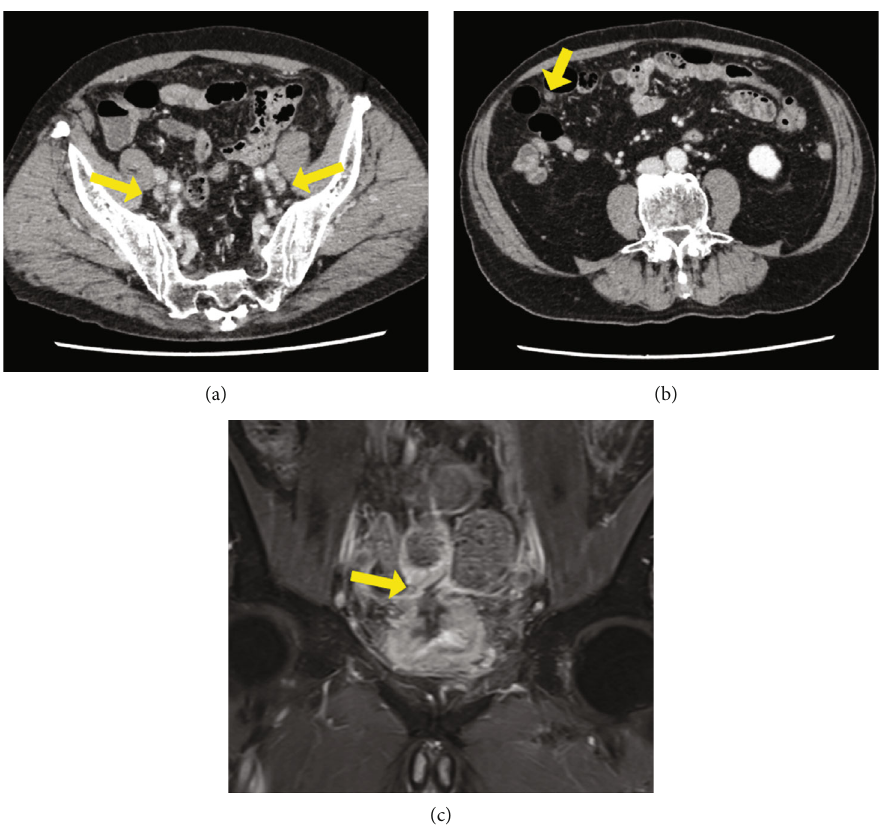
Figure 3: A contrast-enhanced abdominal computed tomography (CT) scan for staging showed bilateral iliac regional lymph node enlargement (a, arrow) and a small nodule in the peritoneum (b, arrow). (c) A T1-weighted TSE magnetic resonance imaging scan for preoperative local evaluation showed that the soft-tissue mass on the bladder wall extended to the small intestine (arrow), suggesting local